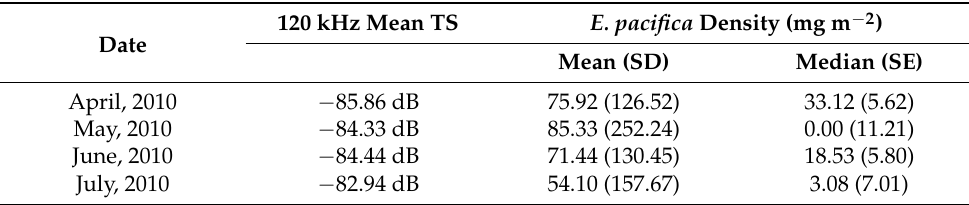
Figure 3. Monthly 8-day average of Chl a concentration from the MODIS Aqua Ocean color data in ( a ) 15–22 April, ( b ) 17–24 May, ( c ) 10–17 June, and ( d ) 12–19 July 2010 in the coastal southwestern East Sea. Table 3. Mean (standard deviation, SD) and median (standard error, SE) of Euphausia pacifica density (g m − 2 ), integrated from 20 m to the bottom from April to July, 2010. The monthly densities were estimated from the 120-kHz S V data using multi-frequency analysis